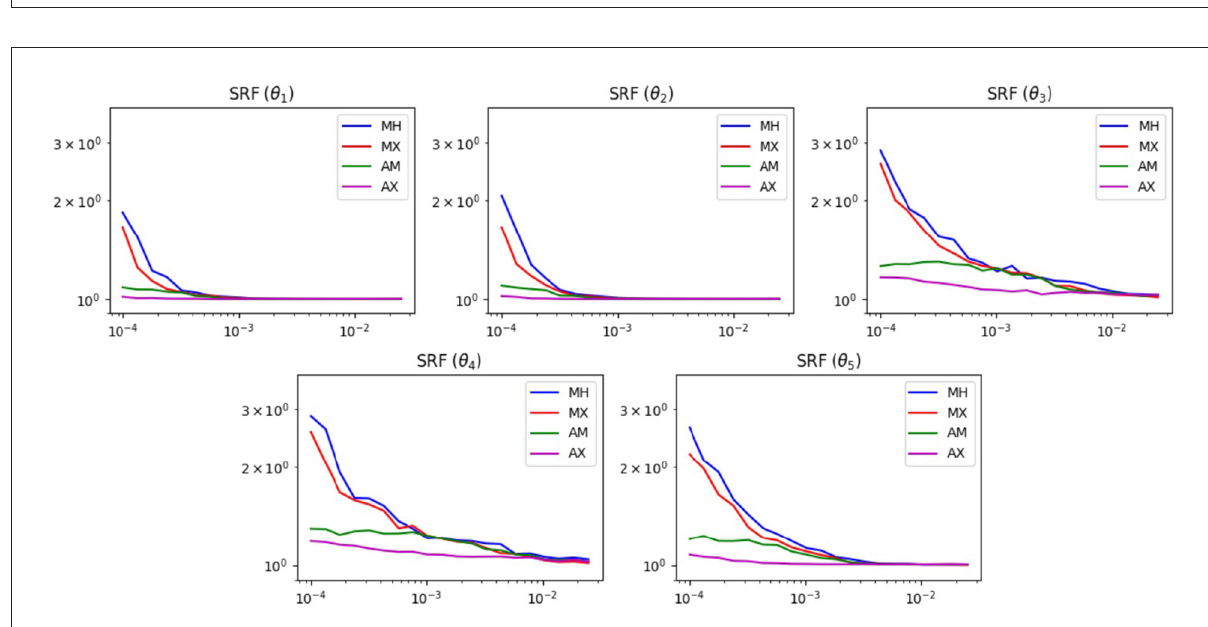
FIGURE9 SRF results of MCMC test on the α − pinene problem. The horizontal axis displays the proposal width (logarithmic scale). The vertical axis is the SRF (logarithmic